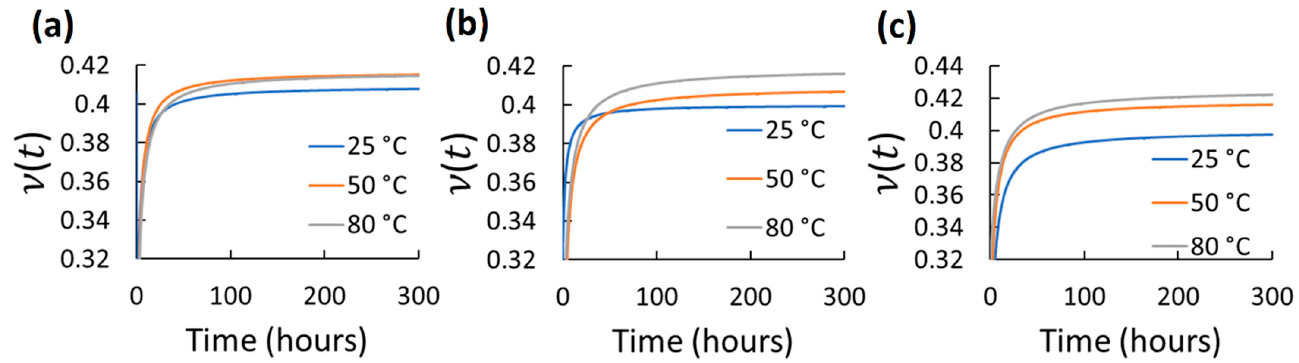
Figure 8. Viscoelastic Poisson’s ratio of FKM at different temperatures and stress: ( a ) 200 kPa; ( b ) 400 kPa; ( c ) 600 kPa.